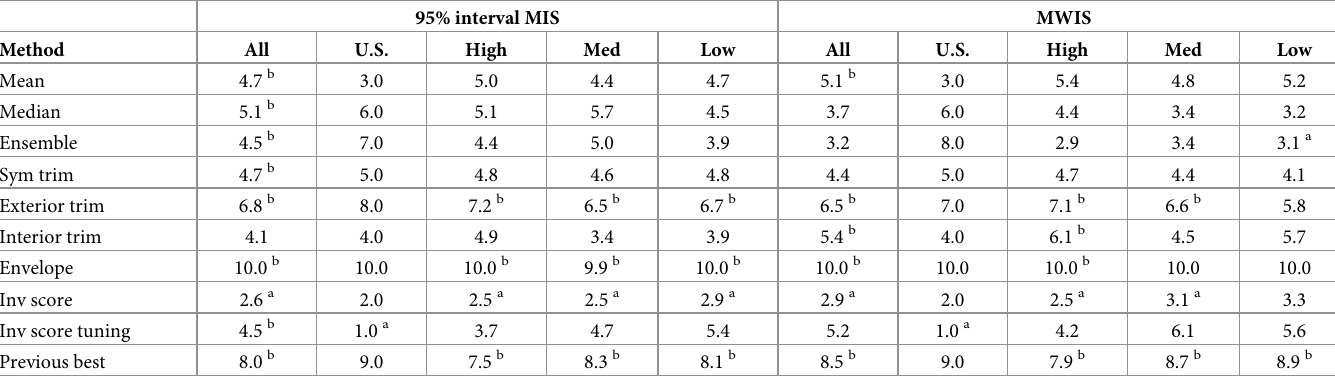
Table 3. For incident mortality, average ranks of the 95% interval MIS and